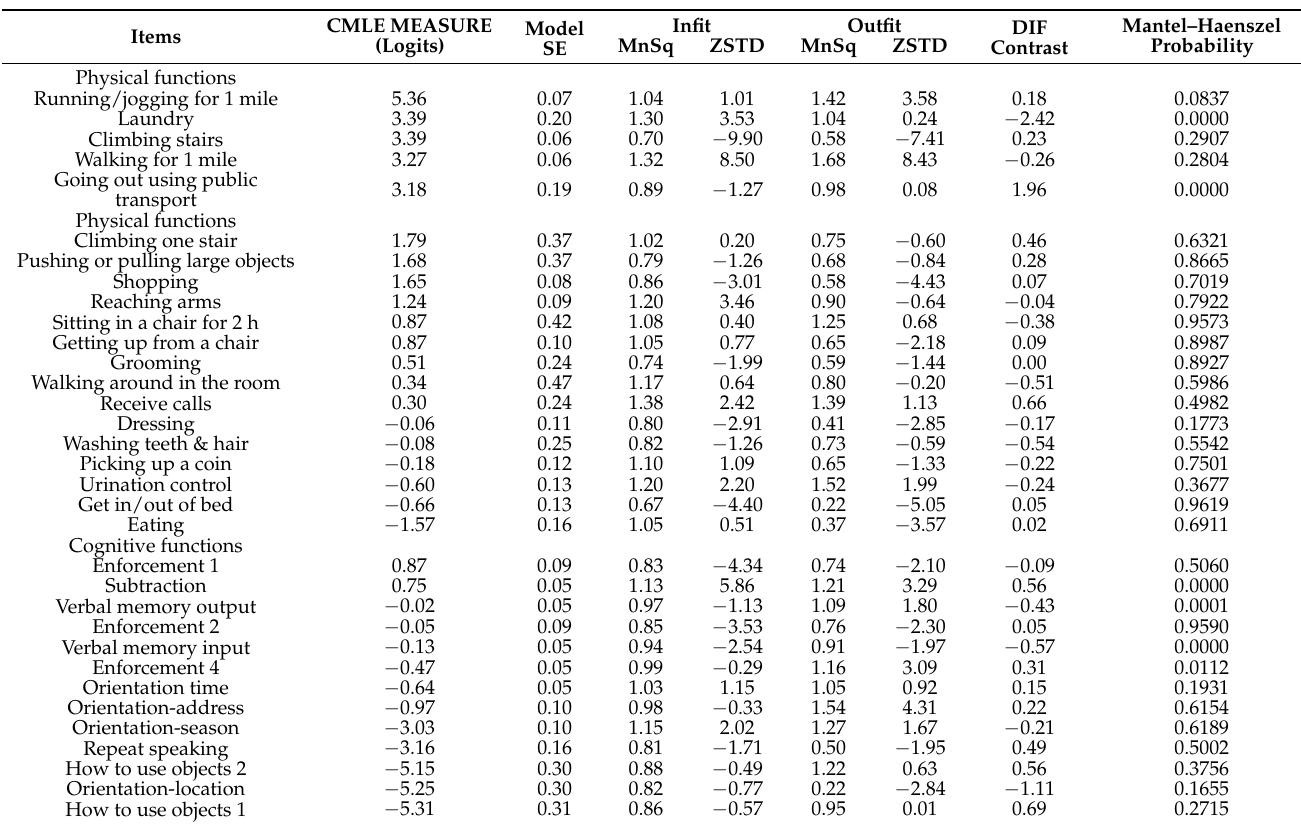
Table 4. Fit statistics of the physical and cognitive function of linking items for the 2011 CHARLS, 2011 JSTAR, and 2010